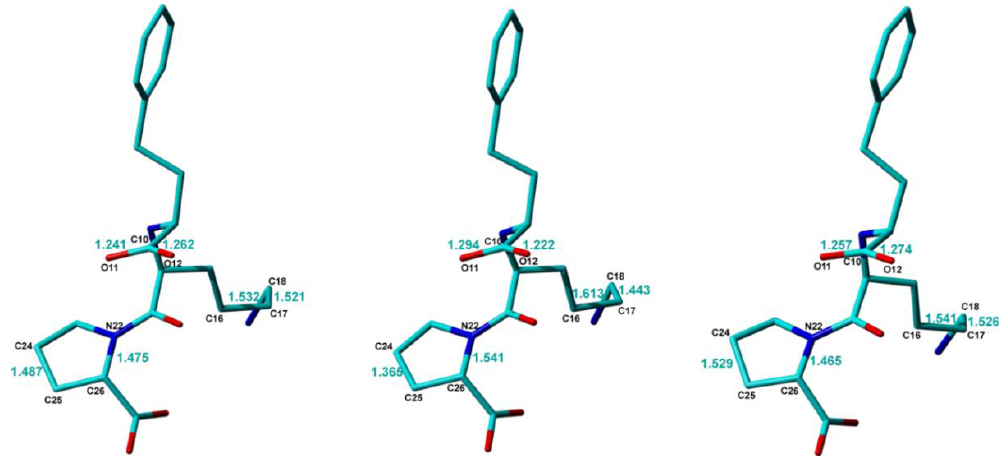
Figure 4. Comparison between the Lisinopril molecular conformations in the three analyzed models, Lisi-SC-XRD ( left ), Lisi-PXRD-Synch ( middle ), and Lisi-NMR-Cryst ( right ). The C–C and C–N bond lengths with differences larger than 0.05 Å , and the C–O lengths within the -C9-OO carboxyl group are highlighted.